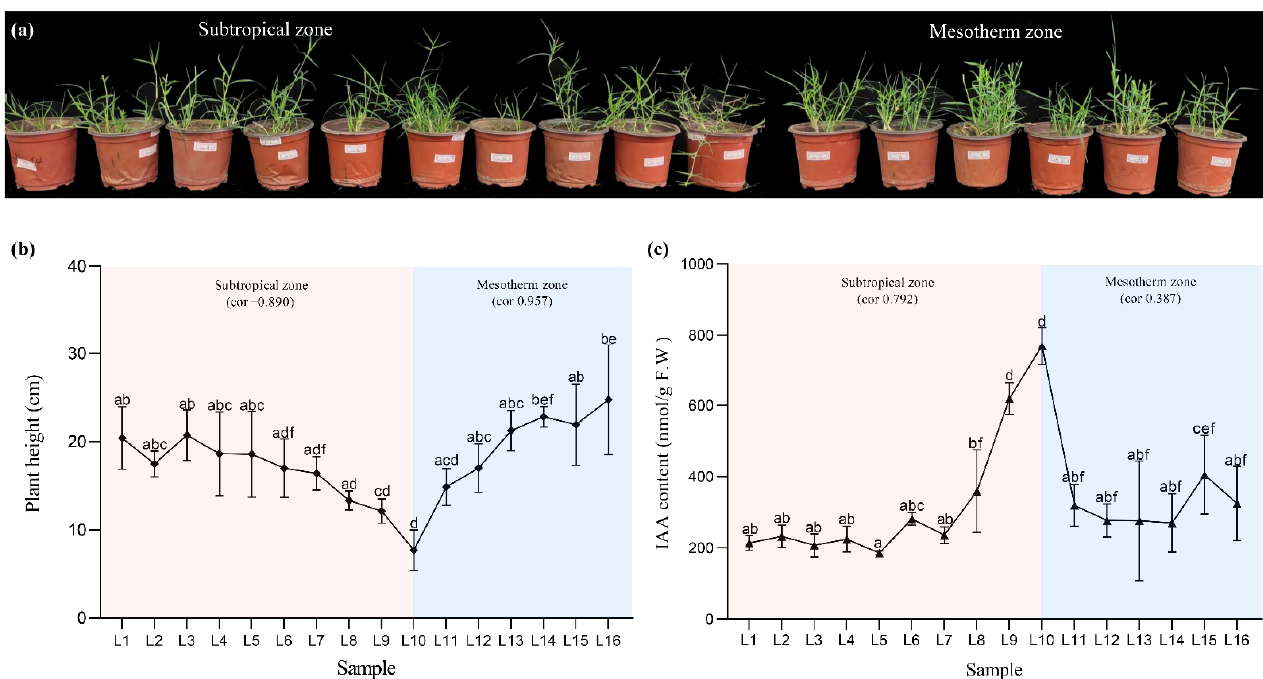
Figure 1. Phenotypic analysis of diverse bermudagrass across a latitudinal gradient. ( a ) Plant morphologies of wild germplasm accessions of bermudagrass. From right to left: L1~L16 (L represents location). ( b ) Natural plant height of tested samples of bermudagrass before mowing. ( c ) IAA content of diverse bermudagrass. Means of three replicates ± standard error is shown. The data were subjected to an ANOVA test to determine the LSD, and bars superscribed by different letters are significantly different at p < 0.05.